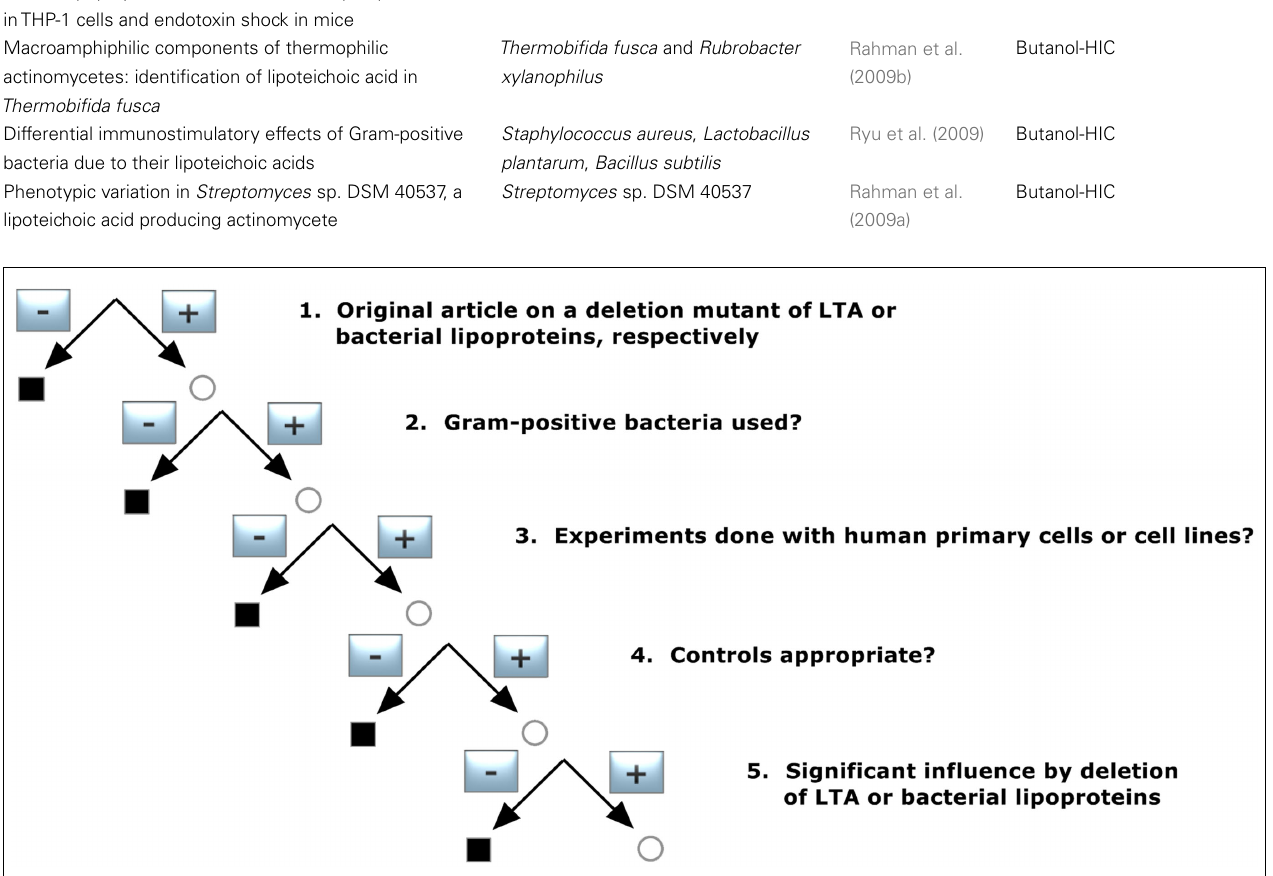
FIGURE 2 | Decision tree 2 (Koch–Dale criterion